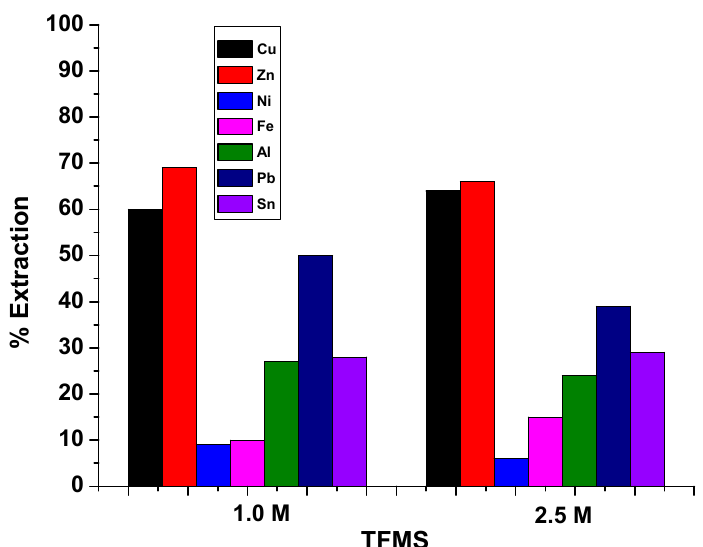
Figure 7. Comparative extraction efficiencies of Cu and Zn, and the co-extraction of other metals from WPCBs using TFMS lixiviant, 50 g/L pulp density, 25 °C, 300 rpm, and 12 h.